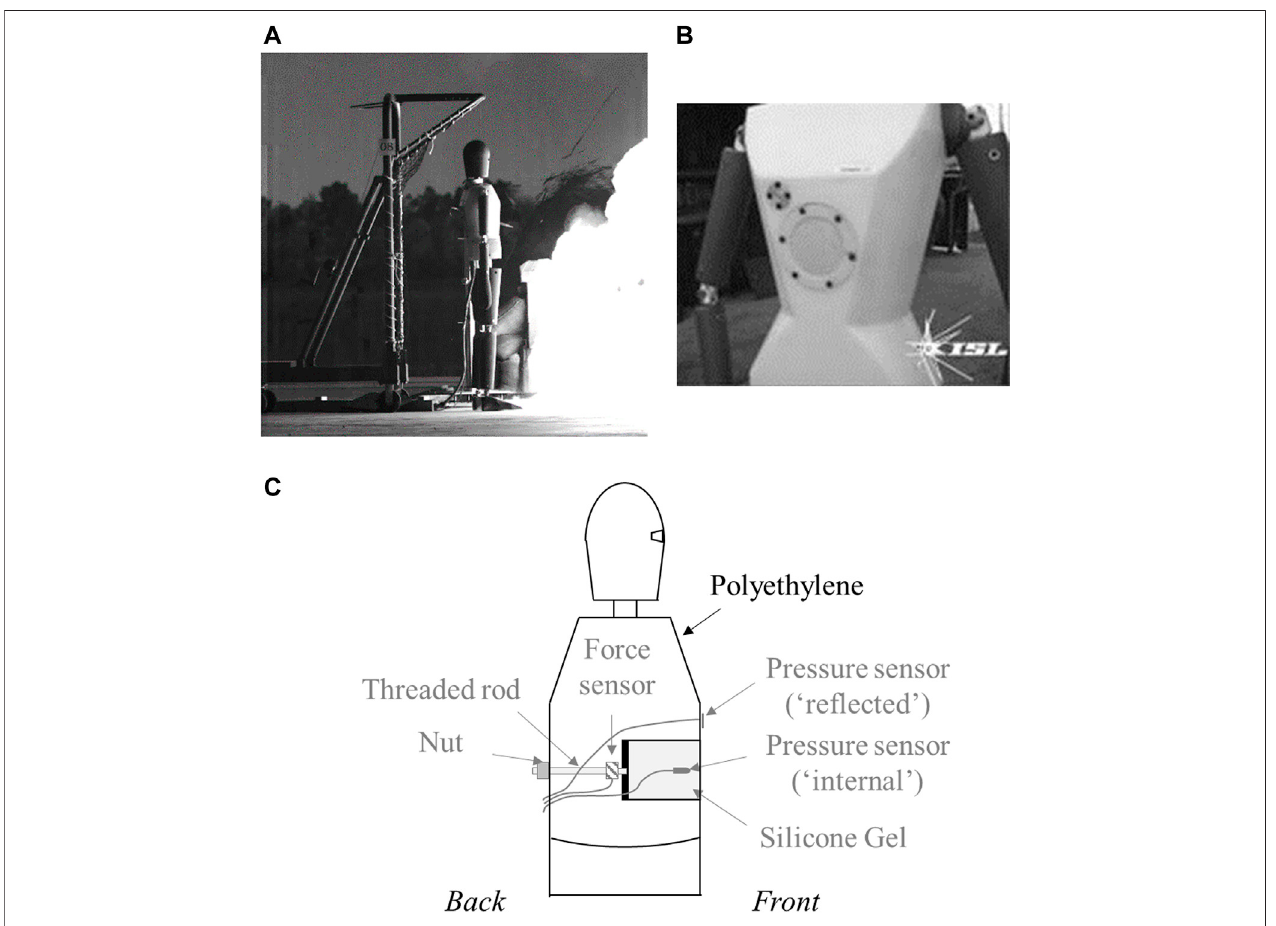
FIGURE 1 | (A) Illustration of BOPMAN exposed to a shock wave in standing position; (B) Zoom view on the thorax; (C) Schematic view of the thorax (side view) with details on the